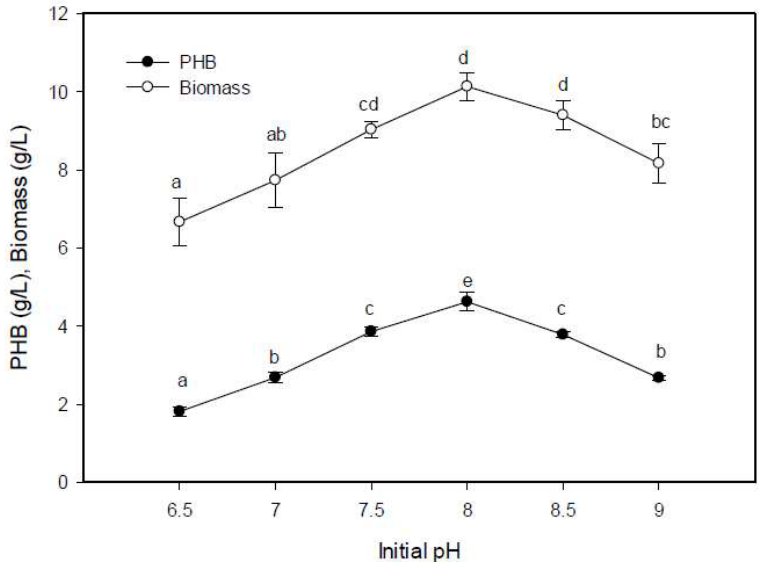
Figure 5. Effect of initial pH on the PHB production by E. aquimaris . The values set by oneself letter(s) on the same line were not significantly different. on the same line were not significantly di ff erent.